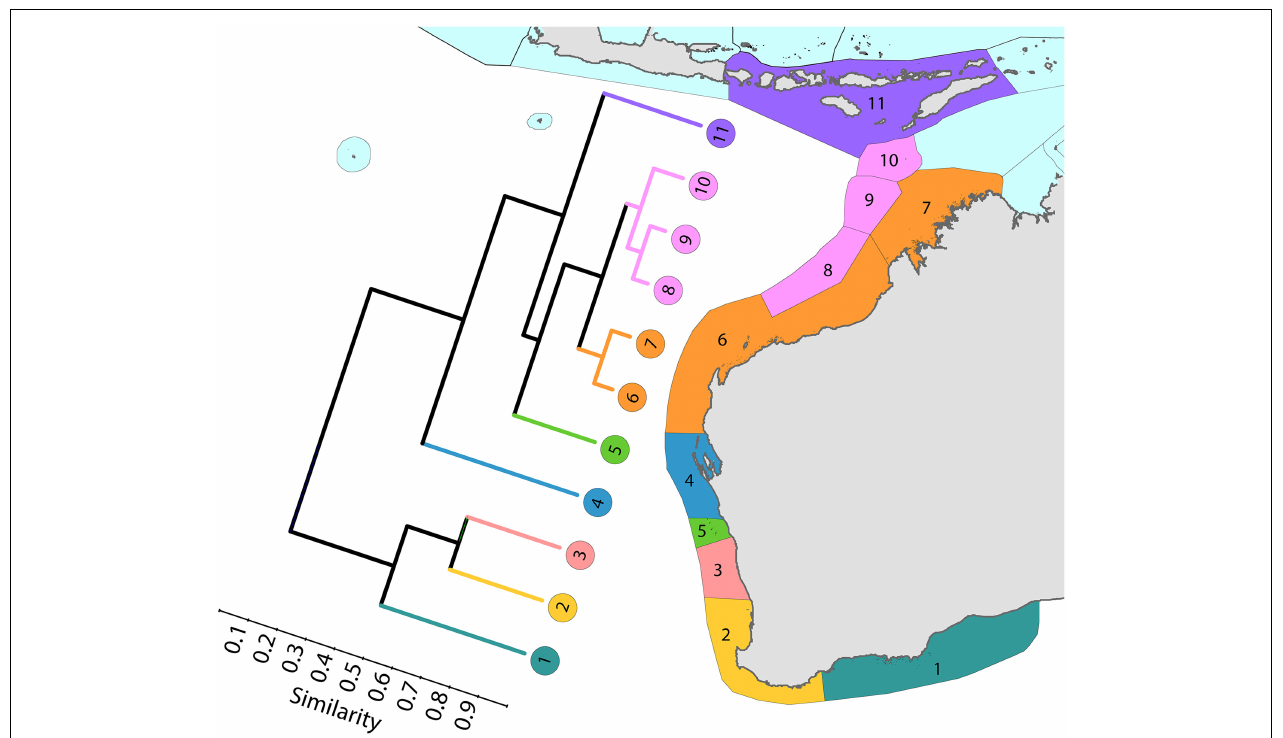
FIGURE 9 | Latitudinal attenuation of affinity and diversity of ecoregions along the path of the Leeuwin Current. The primary divisions in the dendrogram are between the Lesser Sunda Islands of the Coral Triangle (numbered 11), the offshore reefs of NW Australia (numbered 8–10), the